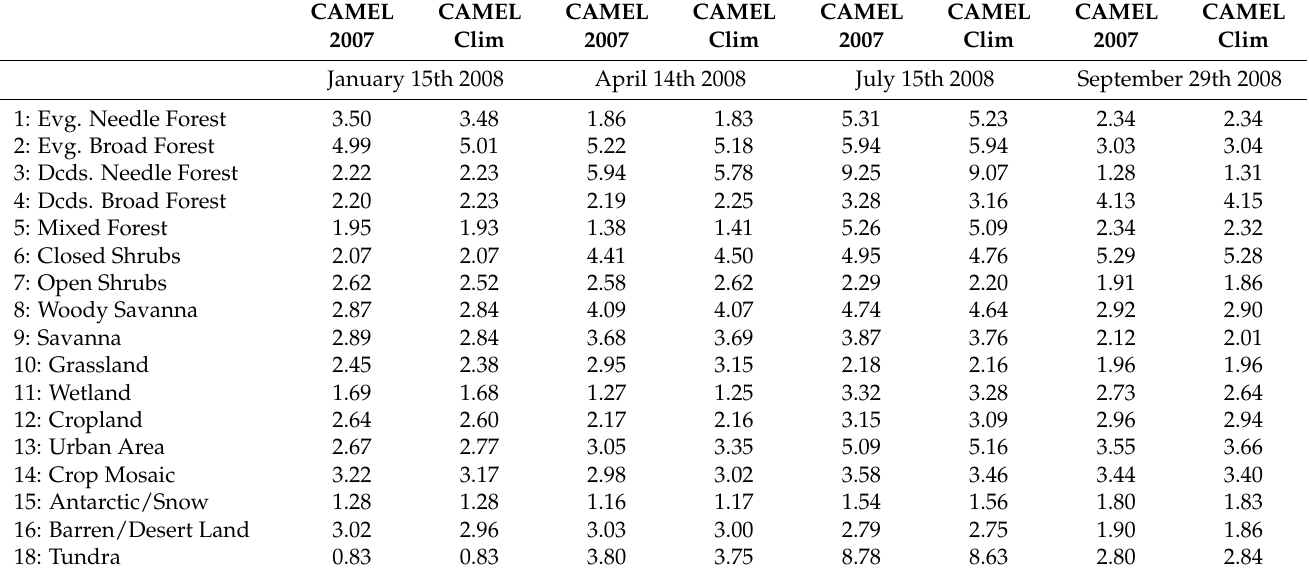
Table 4. Same as Table 3 except for the 8–9 µ m region.